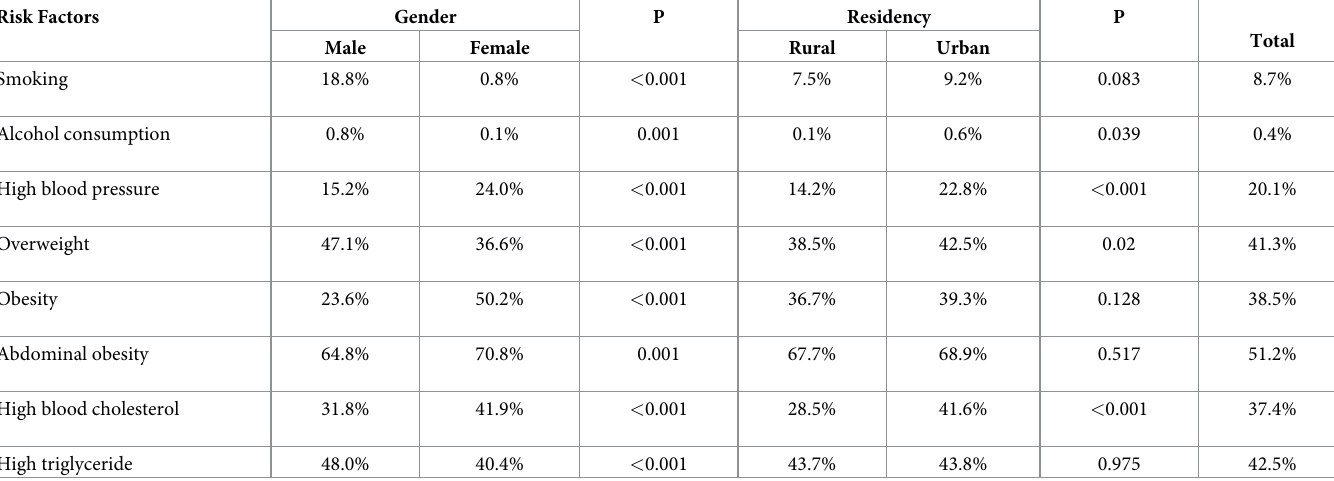
Table 2. The prevalence of risk factors of the type-2 diabetes mellitus by gender and